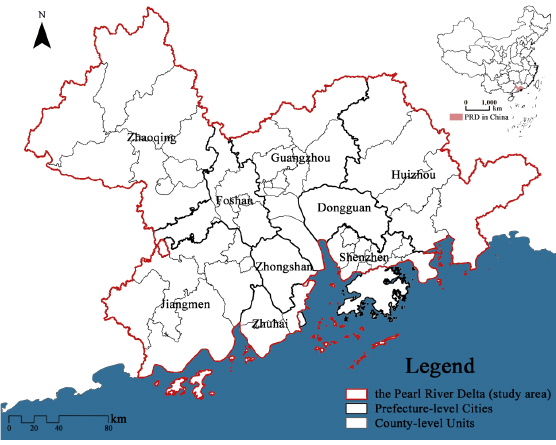
Figure 1 . The layout of the Pearl River